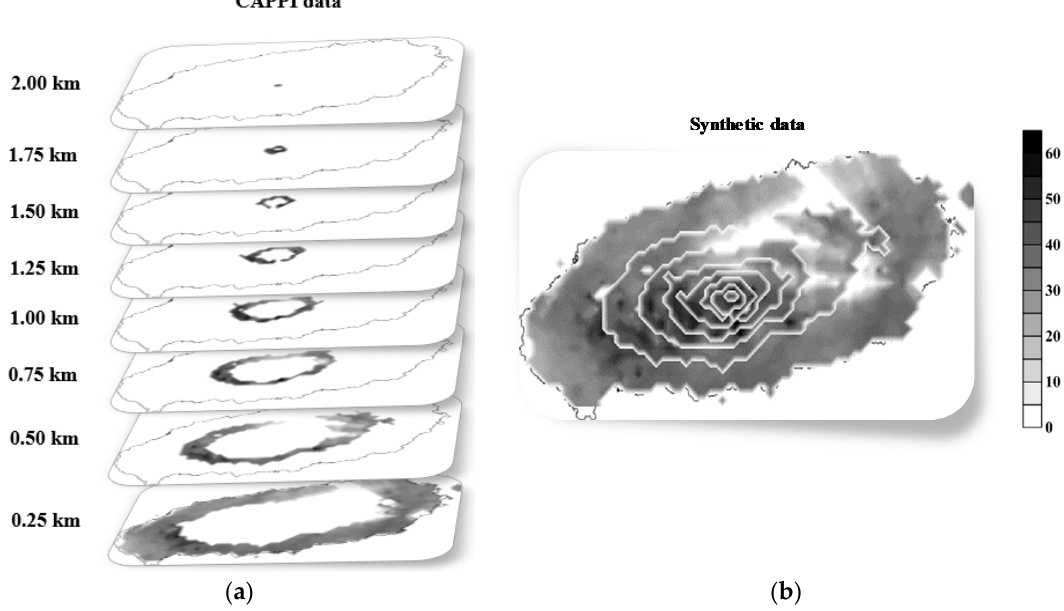
Figure 5. Construction of ground-level radar reflectivity field over the Jeju Island using the radar CAPPI (radar data observed on 0500 LST 2 August 2014). (Each altitude zone radar CAPPI data ( a ), and the radar composite reflectivity field over the entire island ( b )).